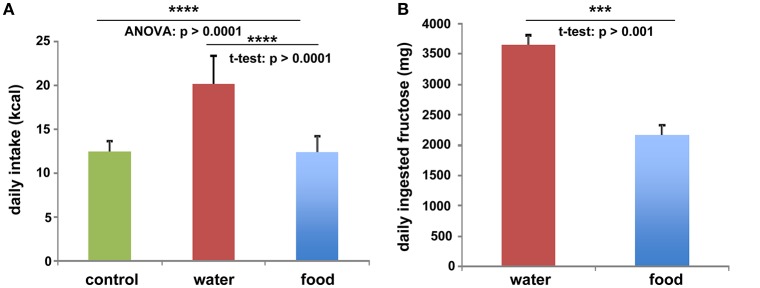
Fructose and energy balance. Averaged values for (A) daily kcal and (B) fructose intake from all animals, irrespectively of feeding times. Differences reaching significance are marked by asterisks (***p > 0.001, ****p > 0.0001).